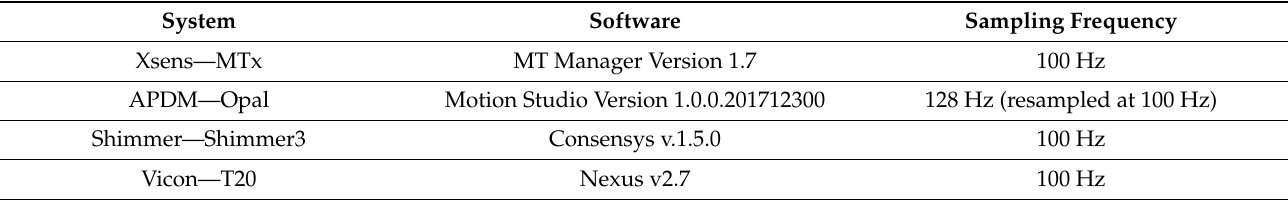
Figure 1. The experimental setup employed. Three pairs of MIMUs were aligned (from the bottom: Xsens—MTx, APDM—Opal and Shimmer—Shimmer3). The LCSs of the MIMUs are represented in blue. The three central markers define the LCS of the SP (in green). The MIMUs and SP systems were arranged so that their axes were aligned with the axes of the board (dashed red arrows). Figure adapted from [9]. Table 3. The STD of the three sensors computed for each of the six MIMUs during one minute of static acquisition. Taken Table 2. Details of data acquisition for each system from [10].